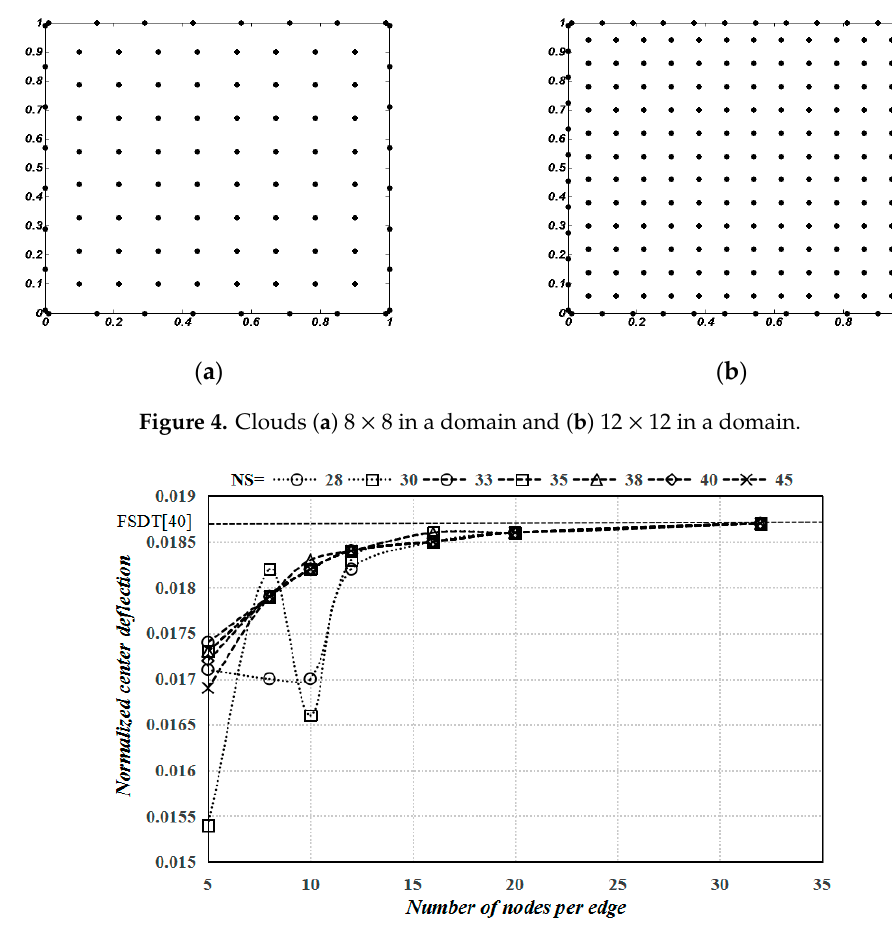
w wE h q = with different values of Al